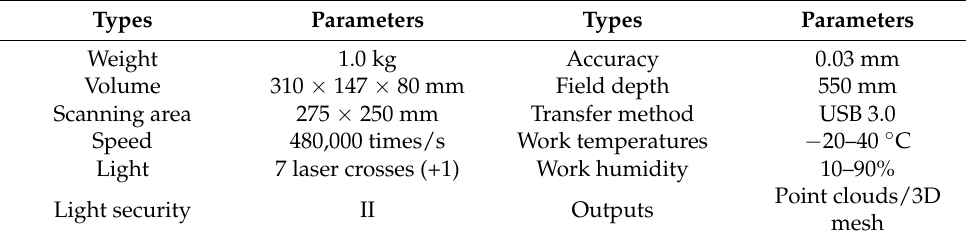
Table 1. Parameters of ZGScan